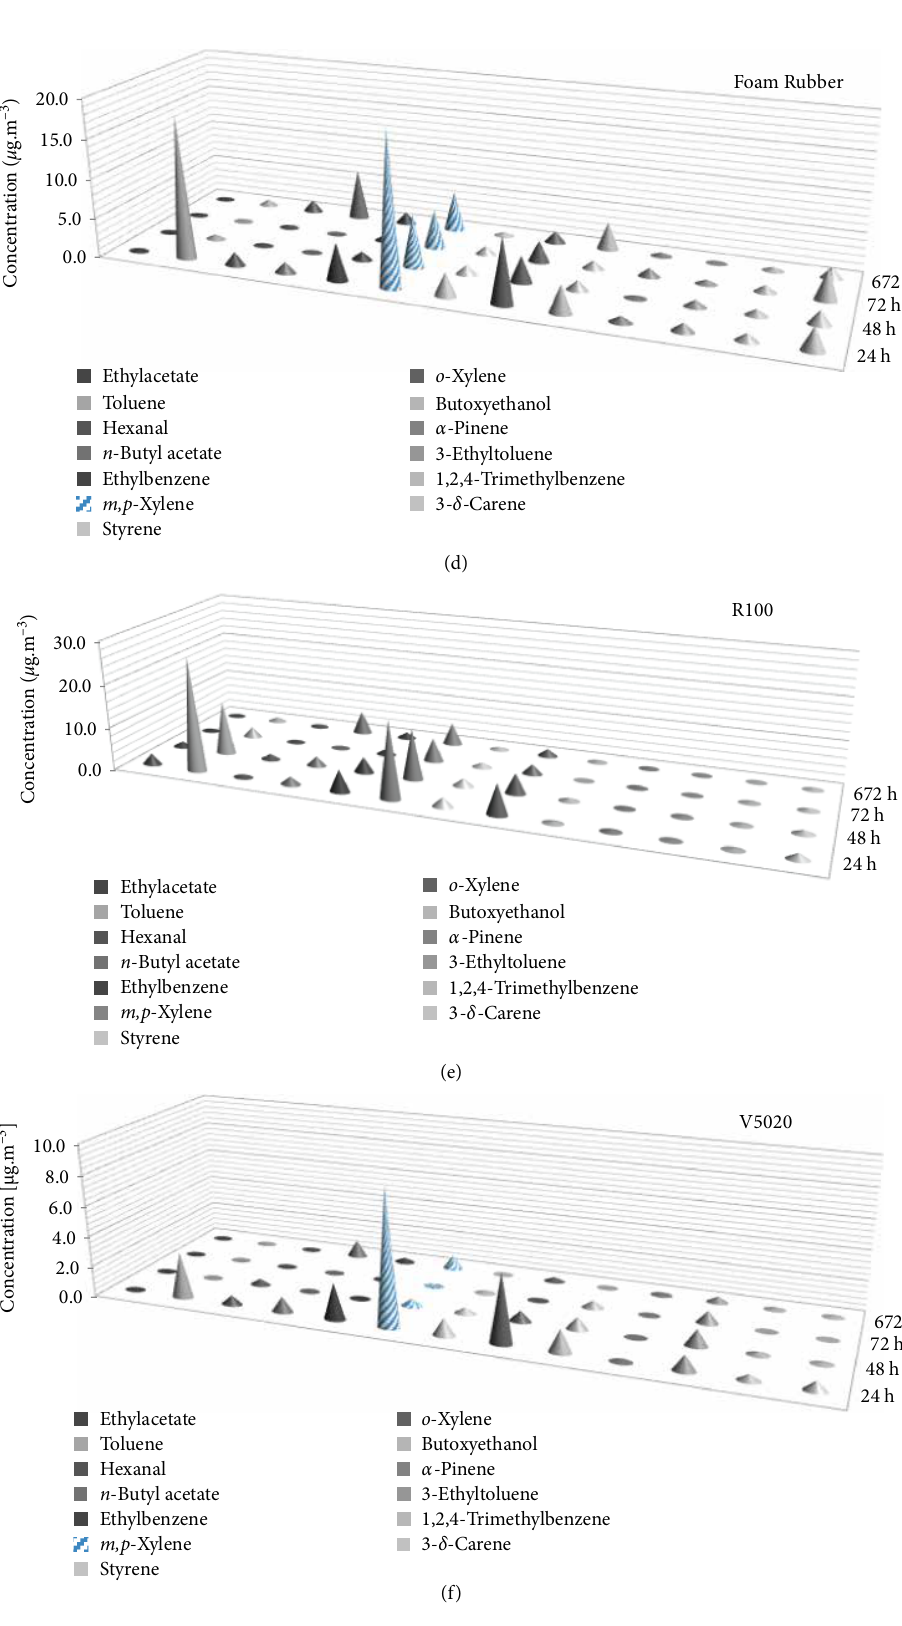
Figure 3: Concentration of Different VOCs emitted by different foams with